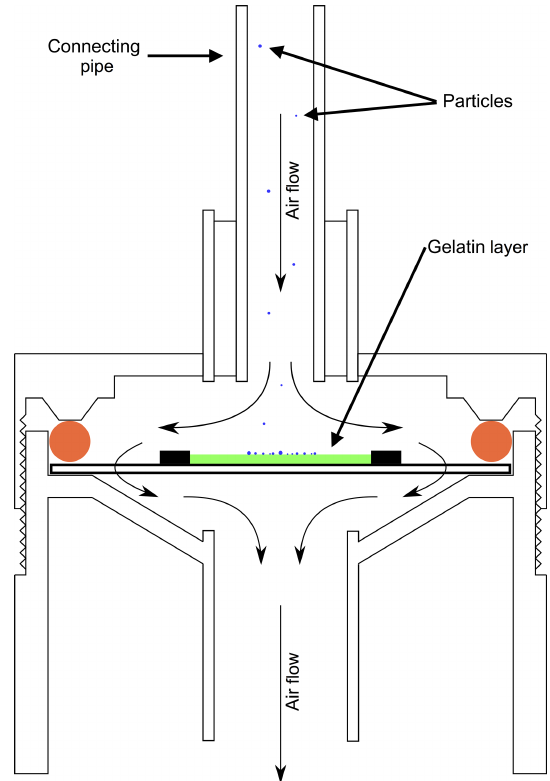
Figure 3. Schematic longitudinal cross section through the impactor used as a particle extractor in the particle collection system. Parti- cles are drawn through the pipe from the top towards the glycerine gelatine-covered microscope slide. Glycerine gelatine is highlighted in green, cross section of silicone O ring in red. Mean impaction ve- locity is about 50ms − 1